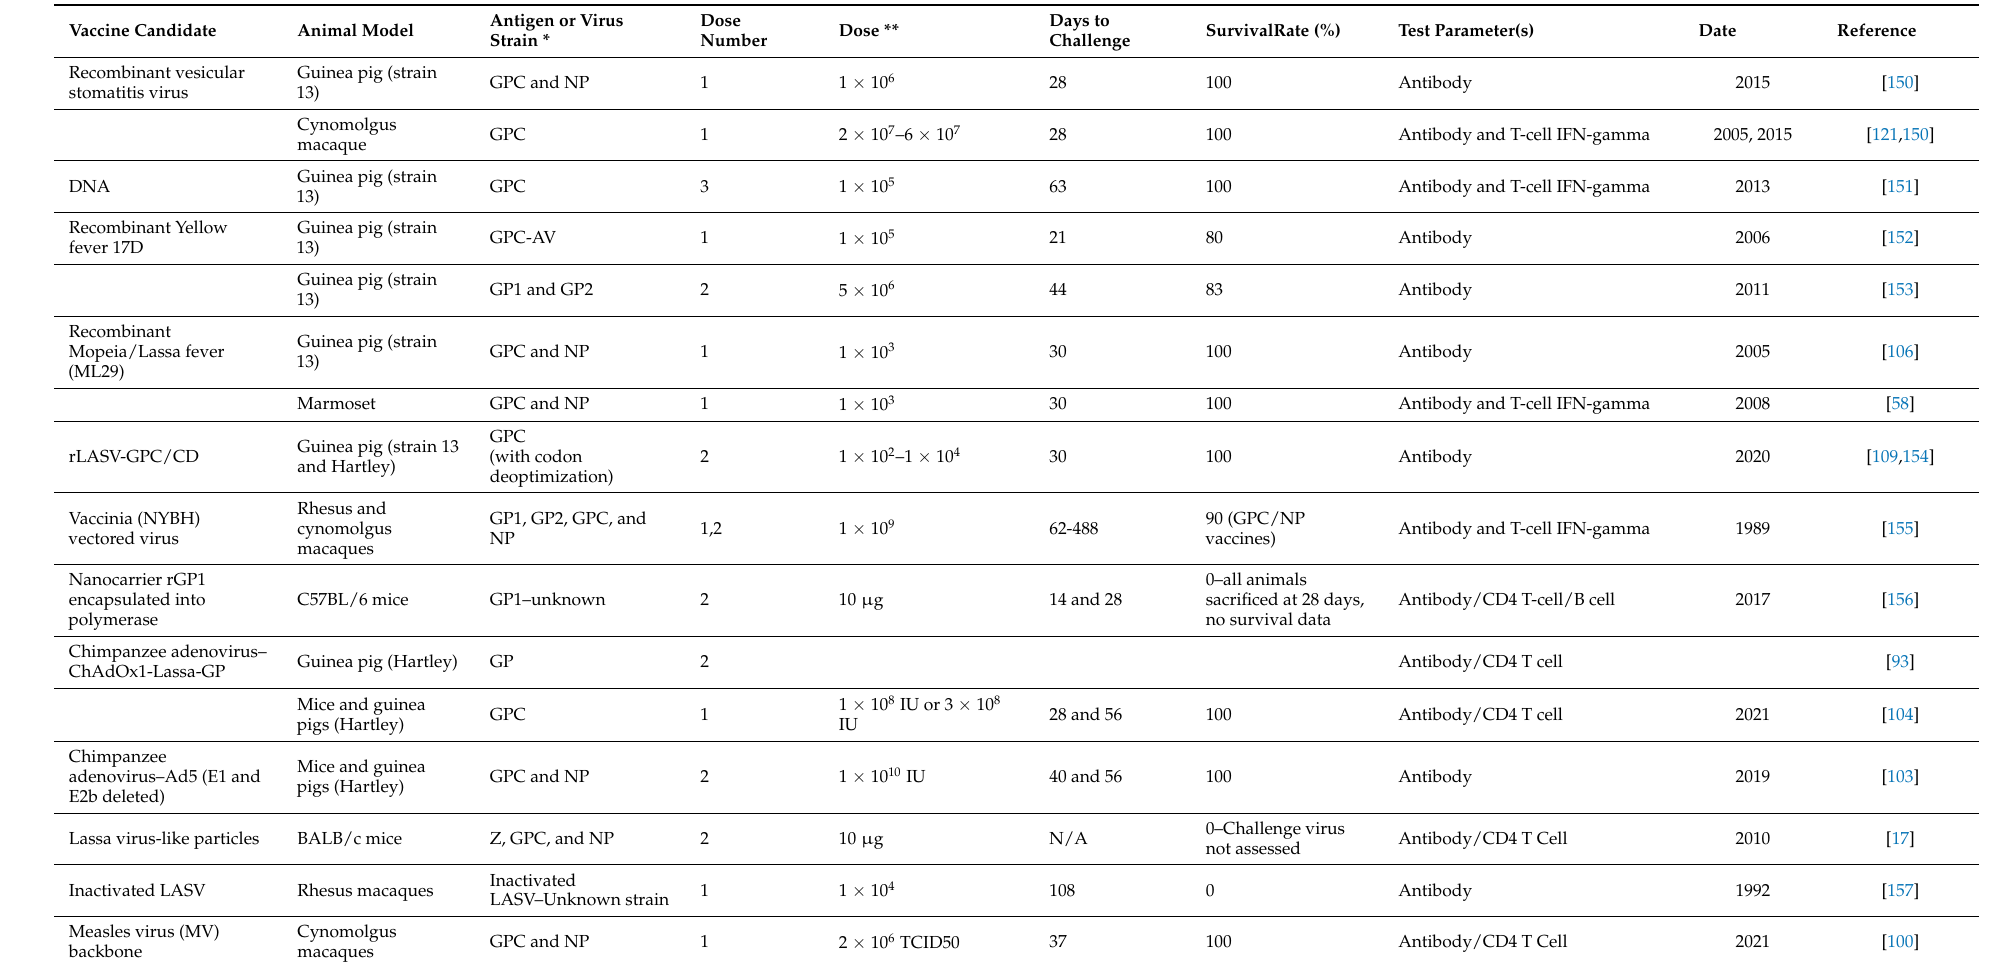
Table 1. Summary of LASV vaccine candidates in preclinical